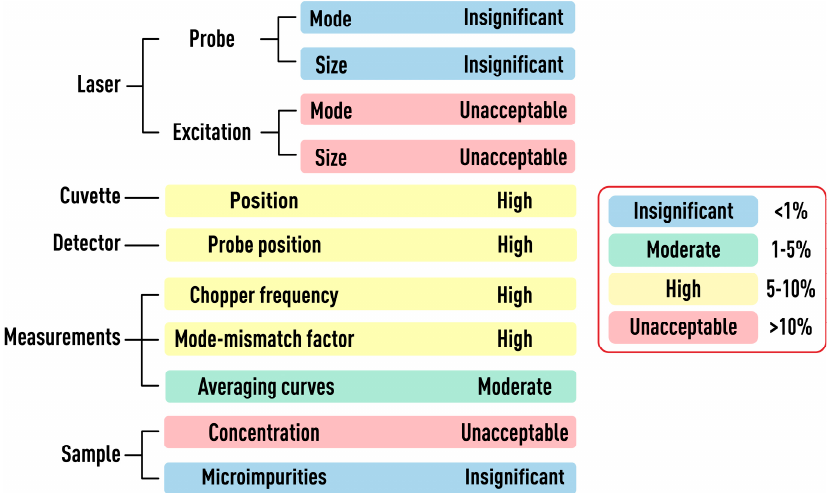
Figure 23. Evaluation of the impact of systematic error sources on the trueness in thermophysical properties by thermal-lens spectrometry.